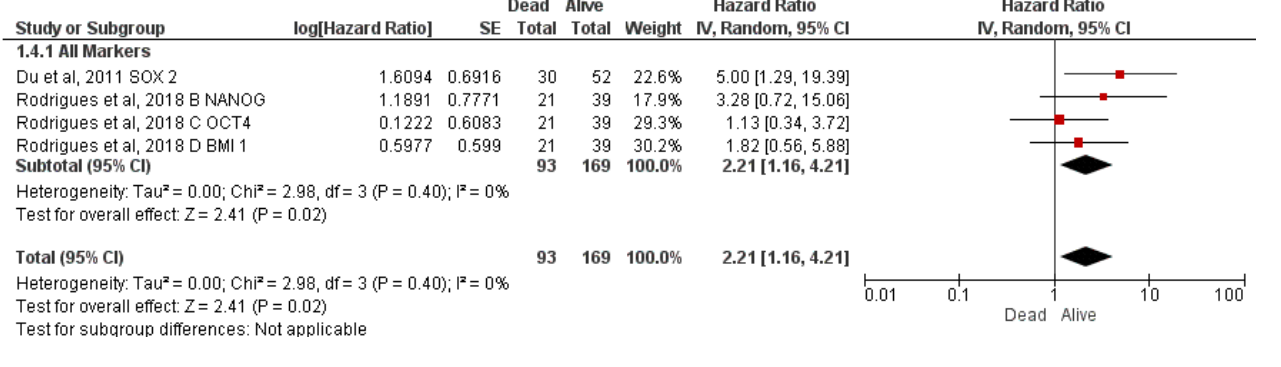
Figure 5. Correlation of CSC markers with overall survival [31,34].